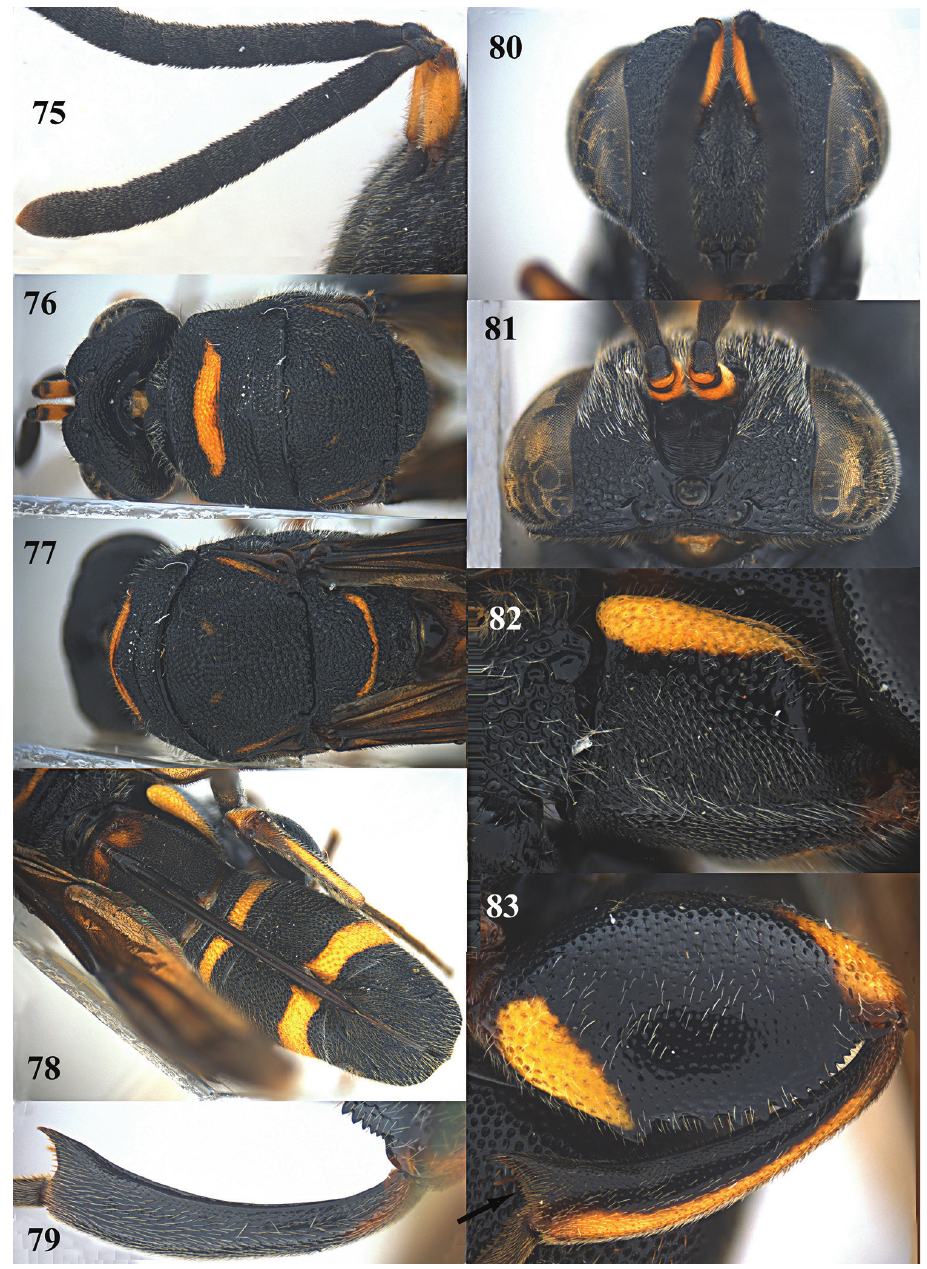
Figures 75–83. Leucospis shaanxiensis sp. n. (but 79 of L. aequidentata sp. n.), ♀ , holotype. 75 Antenna 76 pronotum and mesoscutum dorsal 77 mesosoma dorsal 78 metasoma dorsal 79 hind tibia 80 head frontal 81 head dorsal 82 hind coxa 83 hind femur and